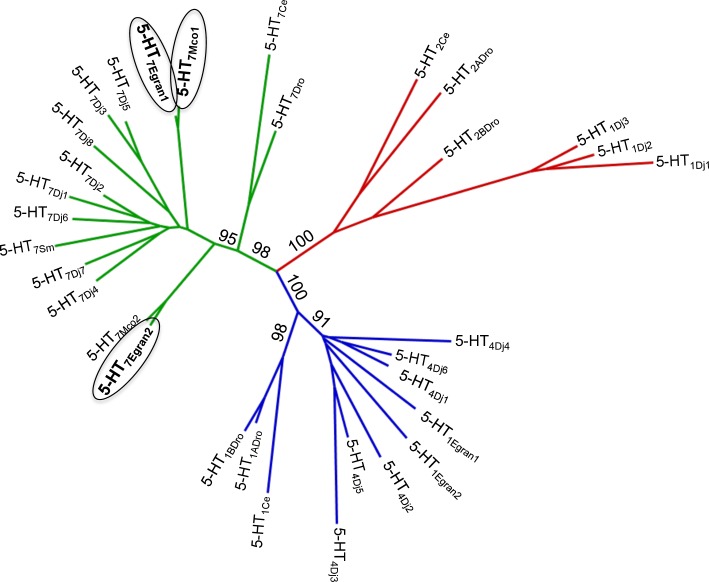
Cladogram of cestode and invertebrate serotoninergic GPCRs.The amino acid sequences of predicted cestode serotonin receptors were aligned with the repertoire of serotonin receptors cloned from various other flatworm and non-flatworm invertebrate model organisms; Dugesia japonica, 5-HTDj; Schistosoma mansoni, 5-HTSm; Caenorhabditis elegans, 5-HTCe; Drosophila melanogaster, 5-HTDm. The cestode GPCR sequences cloned and functionally expressed in this study (5-HT7Egran1, 5-HT7Egran2, 5-HT7Mco1) cluster within a clade of 5-HT7 like receptors (green), as does an additional predicted M. corti sequence (5-HT7Mco2). Other predicted cestode serotoninergic sequences (5-HT1Egran1 and 5-HT1Egran2) cluster within a clade of 5-HT1 like receptors (blue). See methods for complete list of UniProt and GenBank sequence identifiers used in this analysis. Analysis was bootstrapped with 500 replicates.